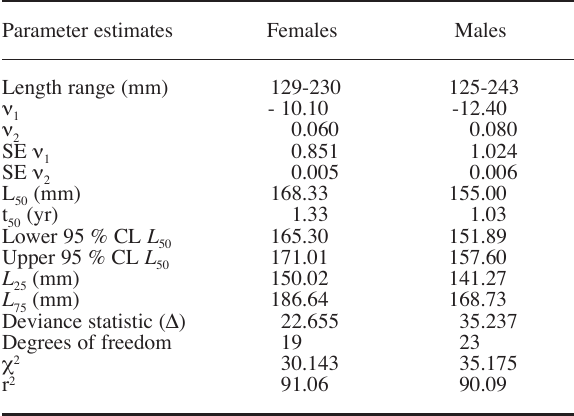
T ABLE 1. – Estimated mean length (L which 50% of the fish are sexually mature and the parameters of